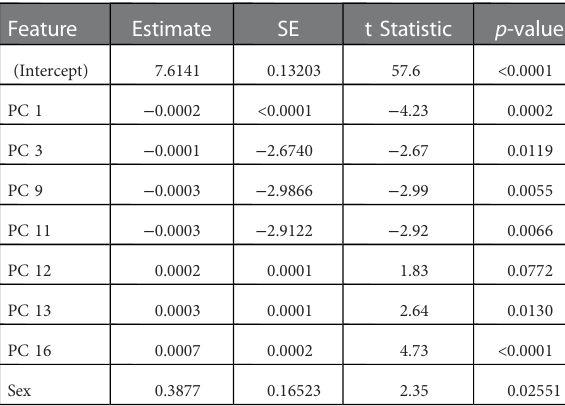
TABLE 2 Description of kinematic stepwise linear regression model. Feature